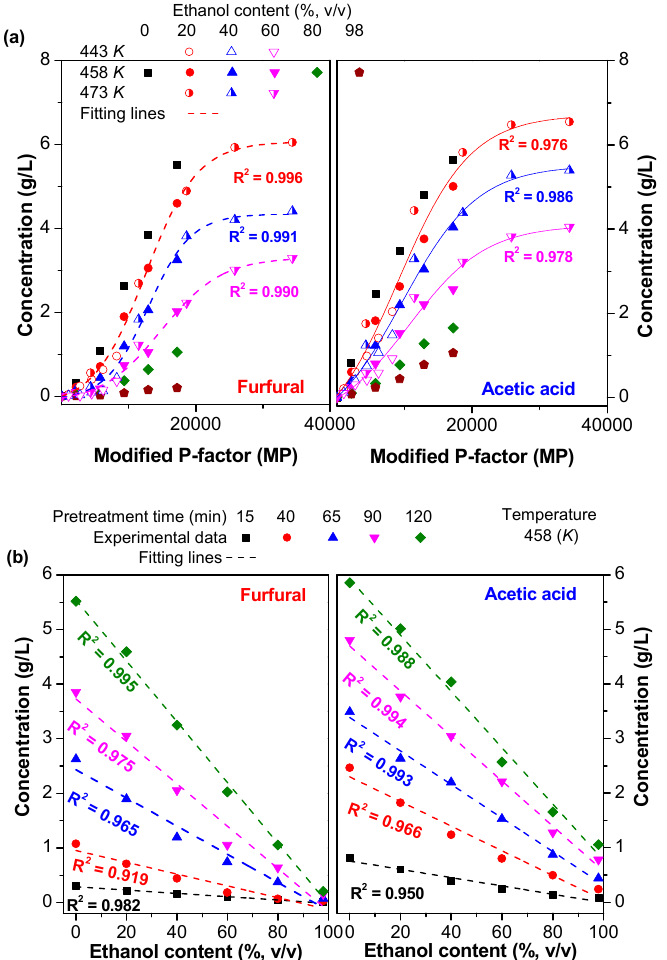
Figure 5. ( a ) Modified P-factor (MP) and ( b ) ethanol concentration dependent furfural and acetic acid concentration during EACO pretreatments.